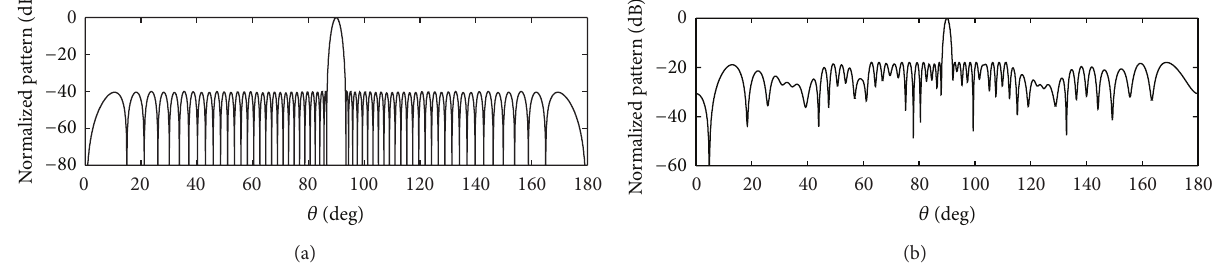
Figure 7: Normalized pattern: (a) amplitude-only tapering and (b) phase-only